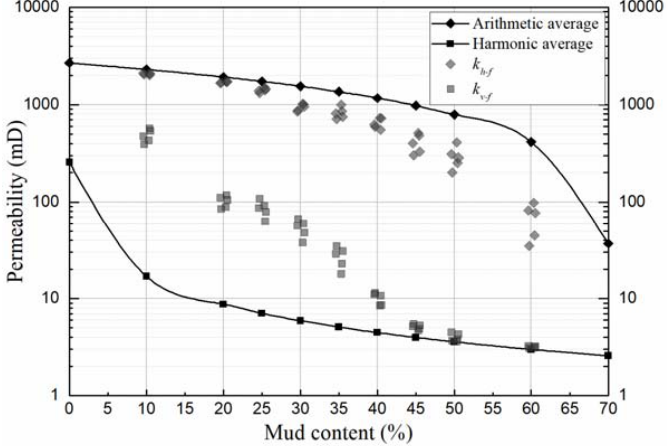
Figure 13. Permeability calculation results of each realization at the full model size (for ISWZs with constant width-10 m). The lines represent the harmonic and arithmetic means of the input permeability values of the fillings.